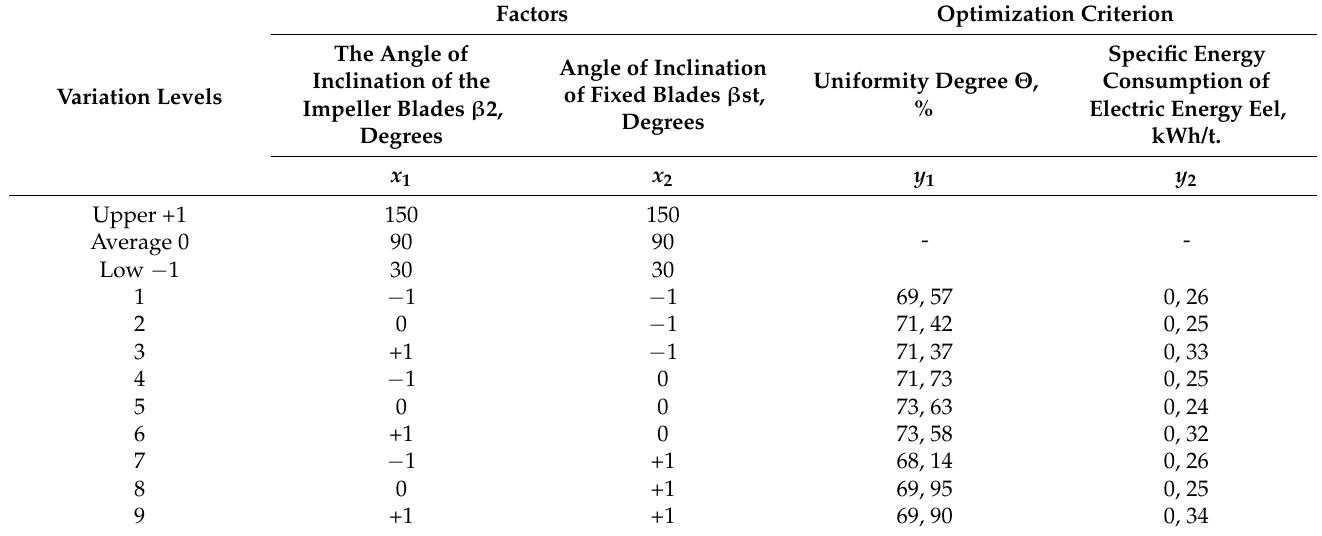
Table 4. Results of research according to plan to determine the optimal parameters 2.